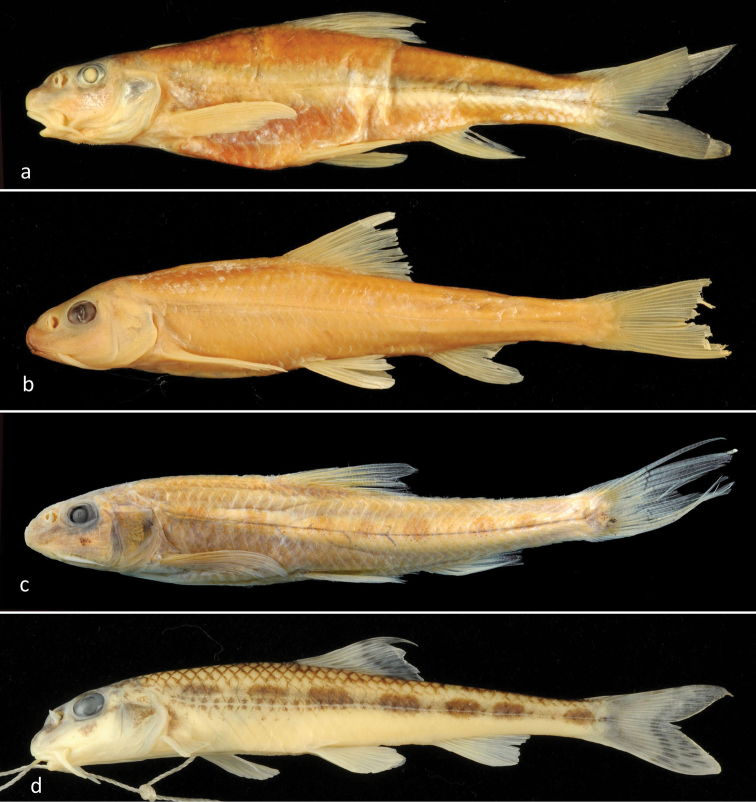
Lateral view of RomanogobioantipaiNMNHS specimen 68.7 mm SL, Danube at Vetren (a) MGAB/BN760 specimen 64.9 mm SL, lower Argeş R. (b) ANSP syntype 47.8 mm SL, Sulina (c) and R.kessleriiNMNHS, 65.7 mm SL, Tsibritsa River (d).